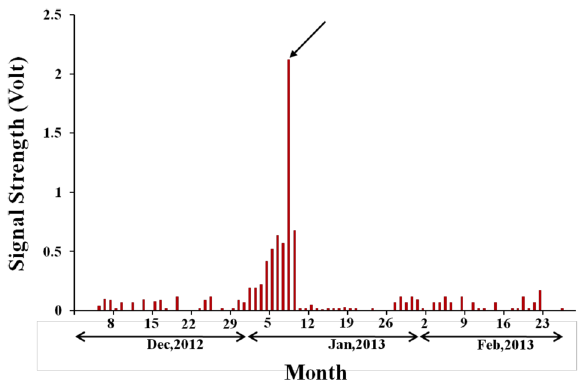
Figure 6. Day to day variations of the maximum temperature (Tmax) from January 1 to January 19, 2013, recorded at GU. The standard deviation magnitude of Tmax from the average values is shown by thick blue lines. The day of attaining a sudden minimum in tem- perature is marked by red arrow head while the black arrow shows the EQ